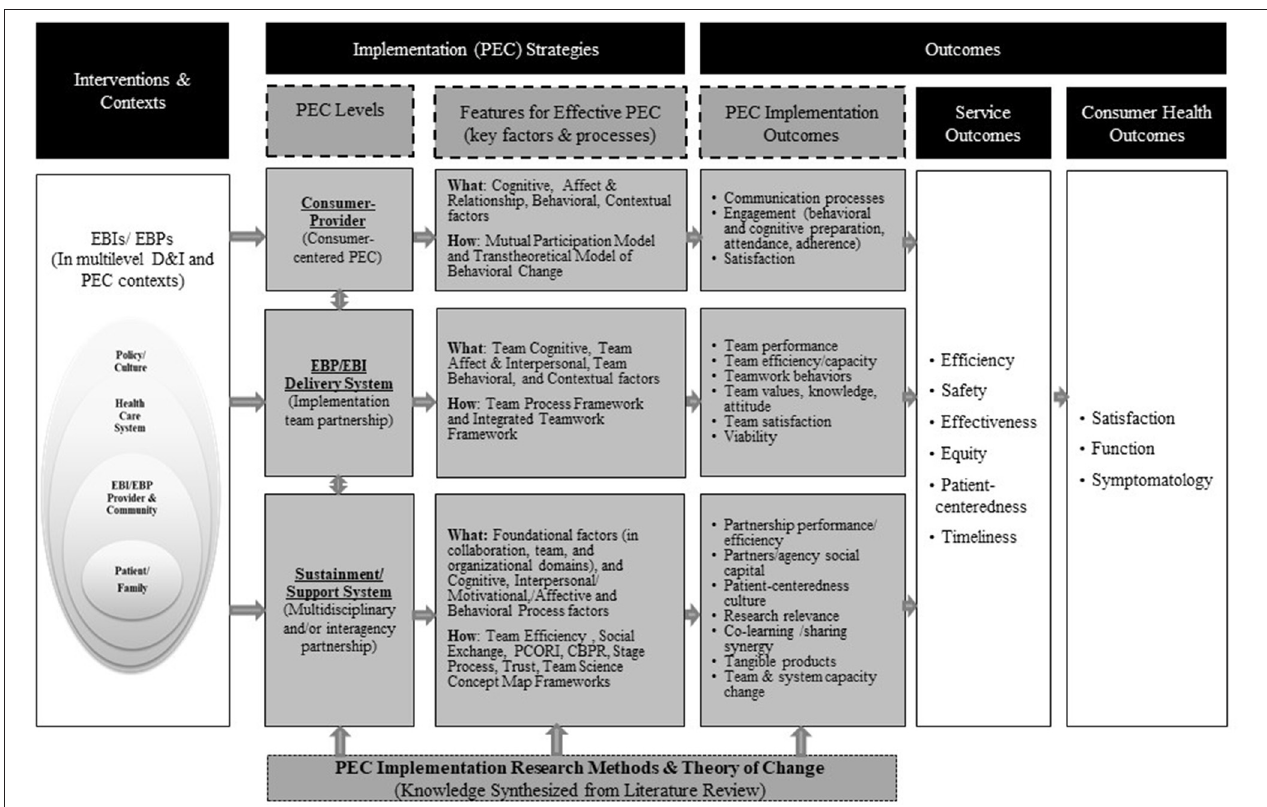
FIGURE 1 | An integrated multilevel partnership, engagement, and collaboration framework for D&I research. Model adapted from Proctor et al.’s (25). Model of implementation research. Each level of PEC represents various types of partnerships. The consumer-provider level includes partnerships between consumers or targets of EBIs/EBPs and implementers who provide EBIs/EBPs. The EBI/EBP delivery system level includes implementation team members from EBIs/EBPs. The sustainment/support system level includes partners for sustainment and sustainability of EBIs/EBPs. Description in boxes “Features for effective PEC” and “PEC implementation outcomes” resulted from the PEC literature